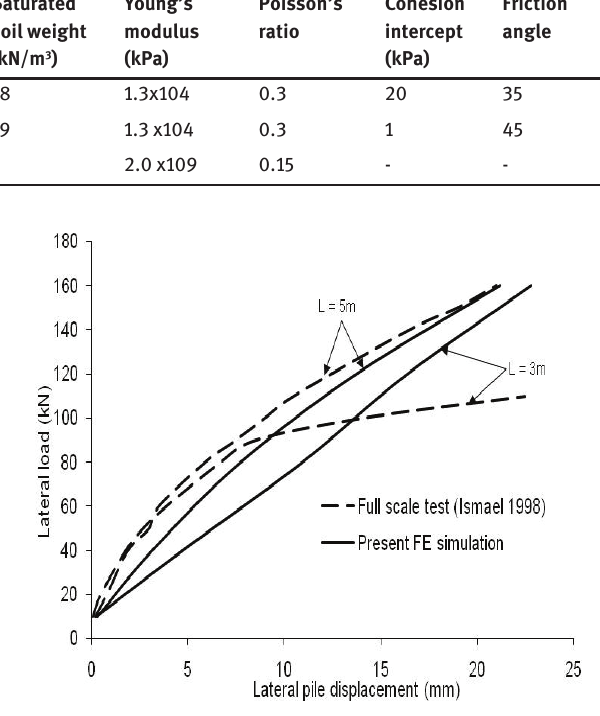
Figure 3 Comparison of finite element results with field test data of Ismael (1998) Figure 3: Comparison of finite element results with field test data of Ismael (1998).